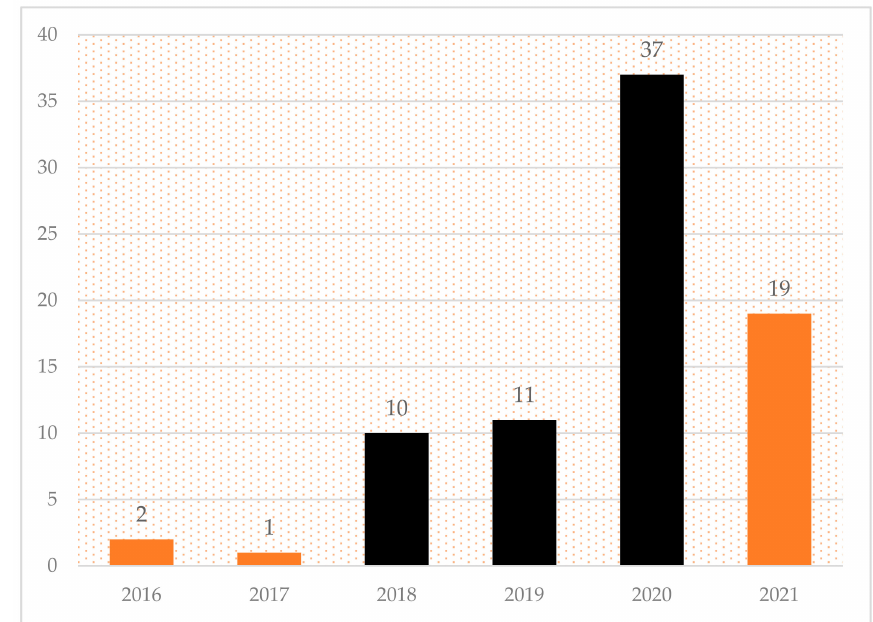
Figure 3. Distribution of studies based on the year of